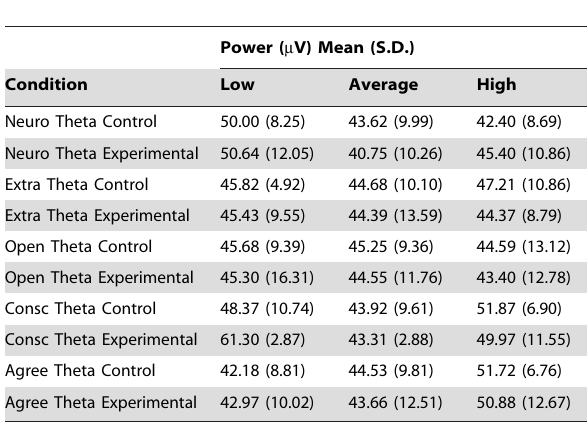
Table 4. Means and Standard Deviations of Cortical Power Spectral Density (in m V) by Condition.